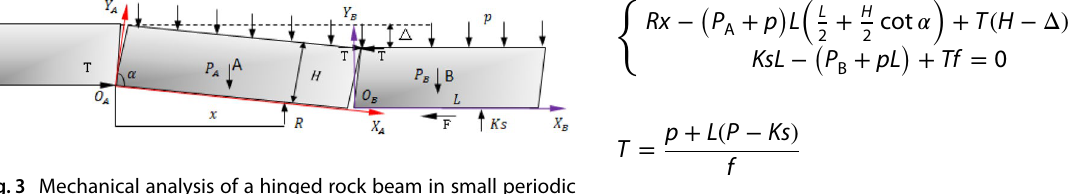
Fig. 3 Mechanical analysis of a hinged rock beam in small periodic